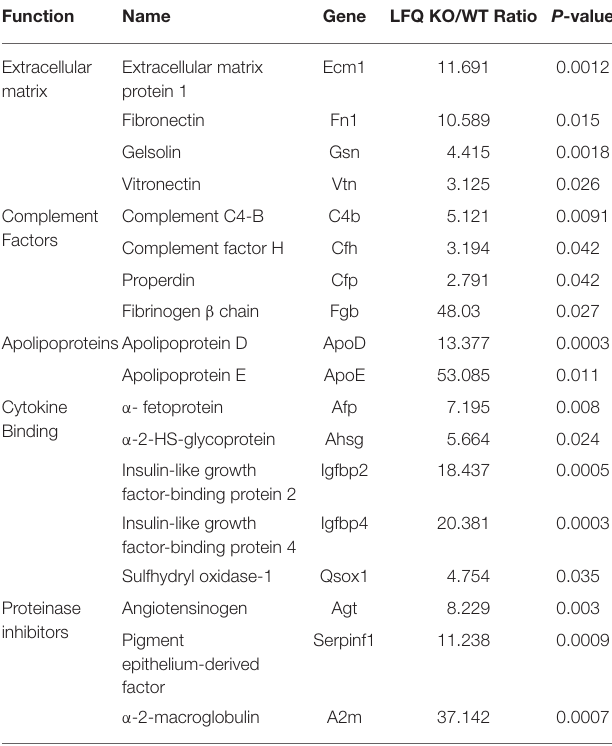
TABLE 1 | List of proteins that were at least twice overabundant in the CSF of Mpdz KO mice relative to the CSF of healthy mice with a null hypothesis probability ( P ) of ≤ 0.05 (Yang et al.,